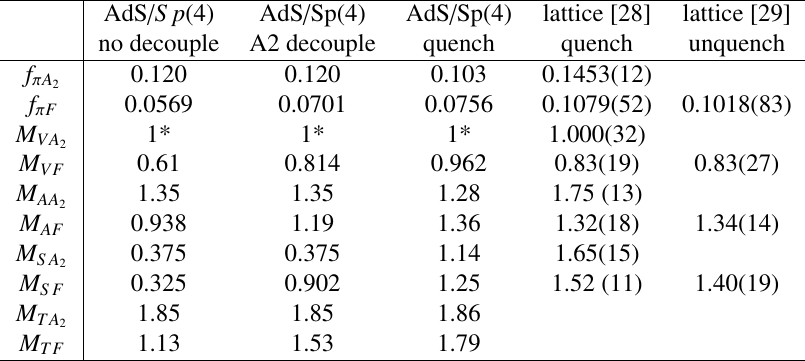
Table 1. AdS / S p (4) 4 F , 6 A 2 . Ground state spectra and decay constants for our various holographic models and comparison to lattice results - we use the subscript A 2 and F for the quantity in each of the two di ff erent representation sectors. Note here for the unquenched lattice results, which do not include the A 2 fields, we have normalized the F vector meson mass to that of the quenched